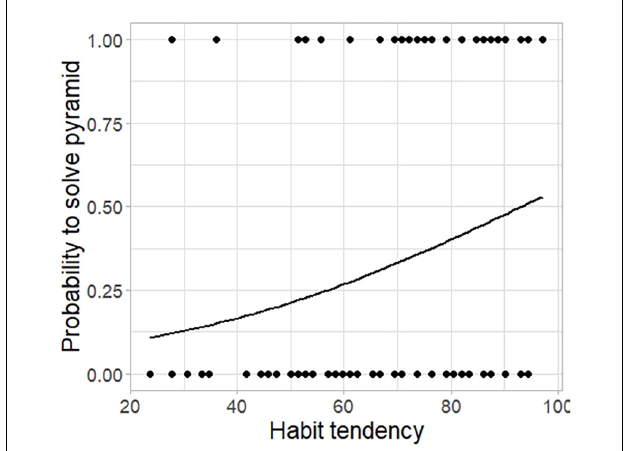
FIGURE 5 | Probability to solve the pyramid puzzle as a function of habit tendency. Probability to solve (binomial response: yes = 1; no = 0) the pyramid puzzle as a function of habit tendency (measured by the SOAT; range: 0–100). A high SOAT score indicates low habit-tendency.